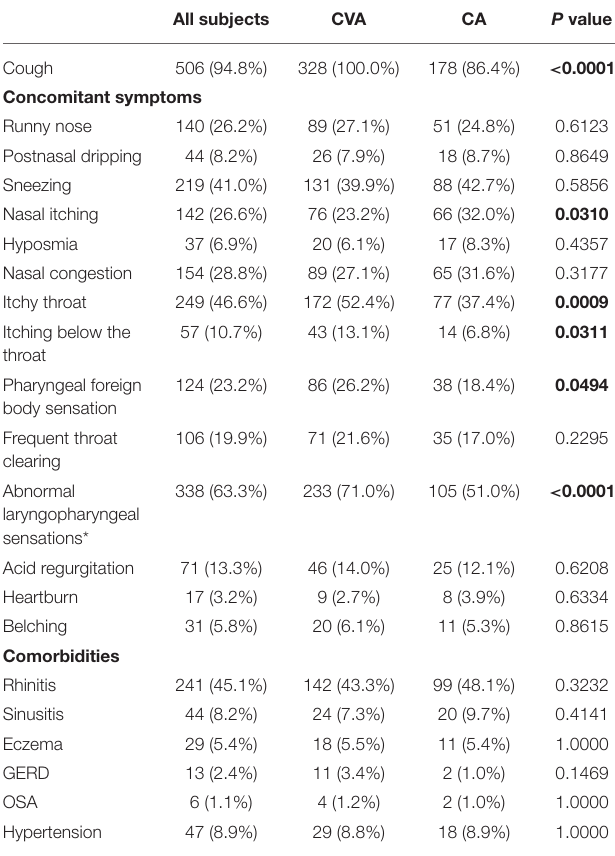
TABLE 1 | Demographic characteristics of subjects. TABLE 2 | Clinical features and comorbidities of